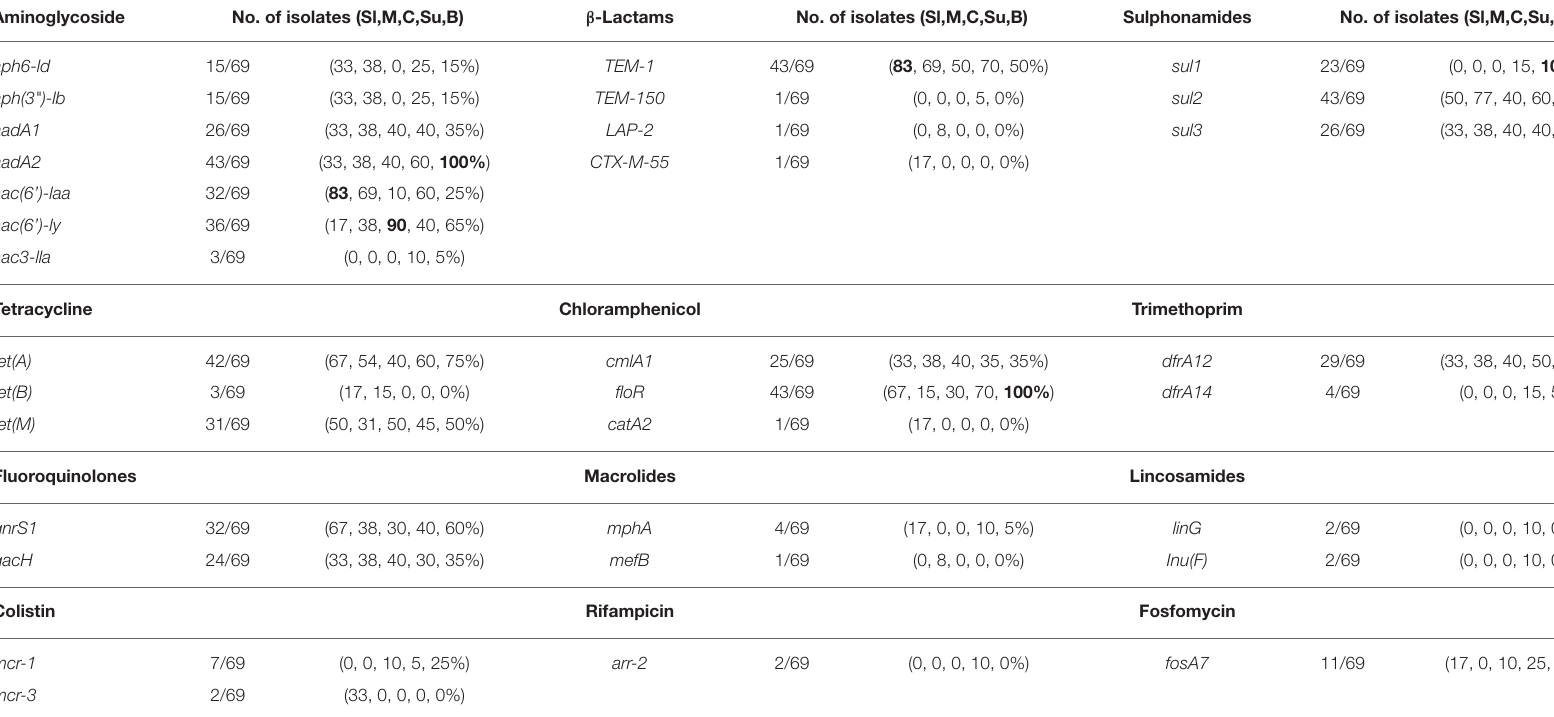
TABLE 3 | Summary of AMR genes found in 69 non-typhoidal salmonella isolates from slaughterhouses and food retail outlet stores. Aminoglycoside No. of isolates (Sl,M,C,Su,B) β -Lactams No. of isolates (Sl,M,C,Su,B)